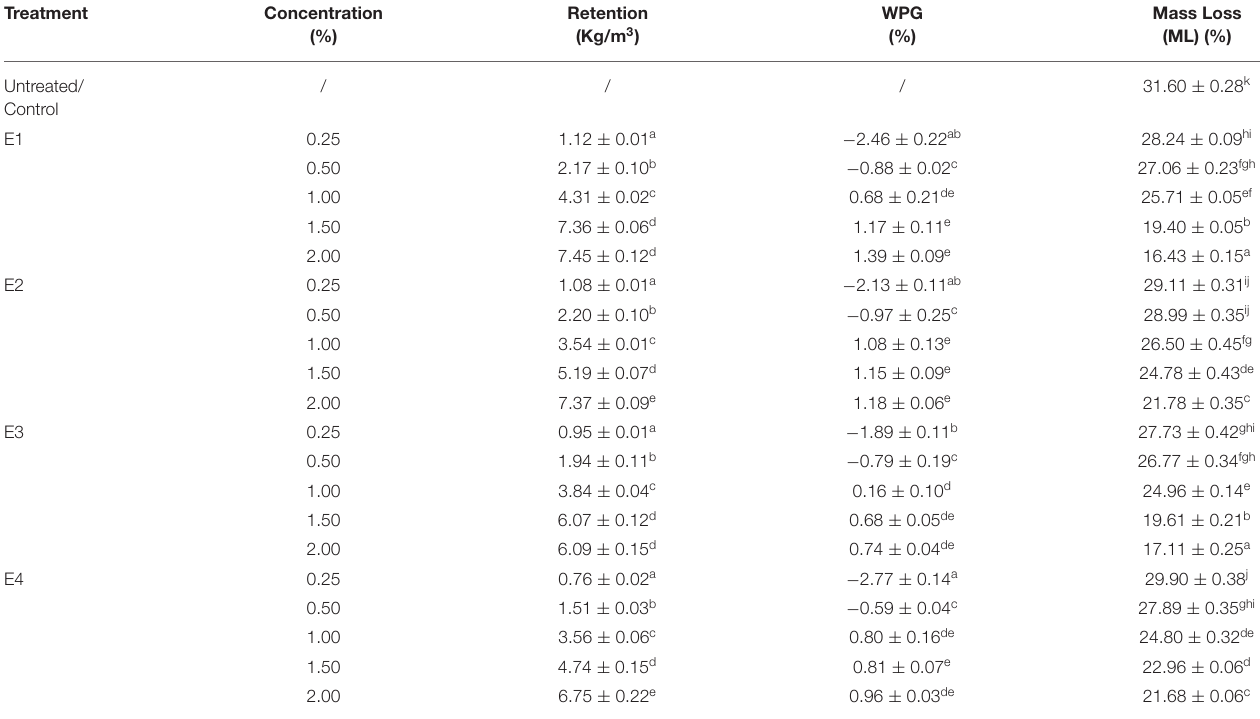
TABLE 1 | Retention (kg/m 3 ), weight percent gain (WPG, %), and mass loss (ML, %) of untreated and plant extracts treated Lannea coromandelica wood blocks. Treatment